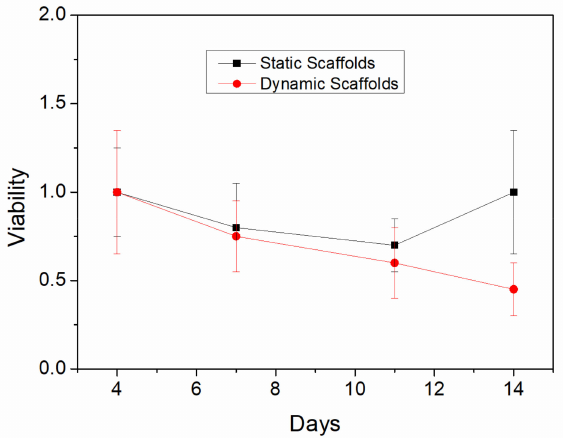
Figure 3. Cell viability of the PCL/elastin scaffolds after a static and dynamic protocol in a